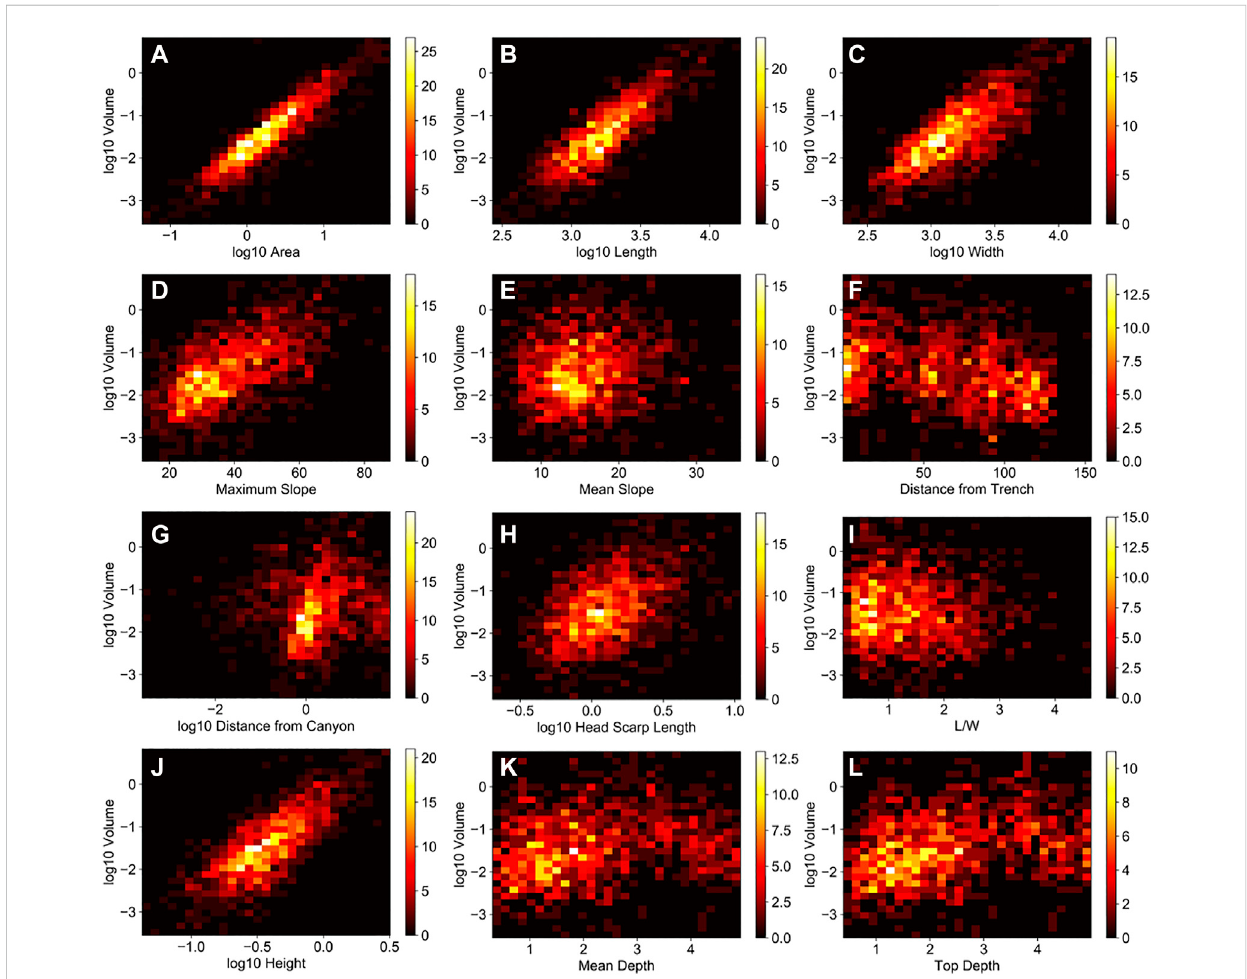
FIGURE 8 2D histograms of submarine landslide parameters with respect to volume (refer to Figure 7 for units). Size-dependent parameters such as (A) area, (B) length, (C) width, (H) head scarp length, and (J) height show a positive correlation with volume. The (D) maximum slope also shows a positive trend with volume. Other parameters (E-L) have a weak association with volume, but an apparent inverse trend can be observed with (F) distance from the trench and (I) L/W. Volume is observed to increase with (K, L) depth up to around 3 km and then shifts to a negative trend toward 5 km